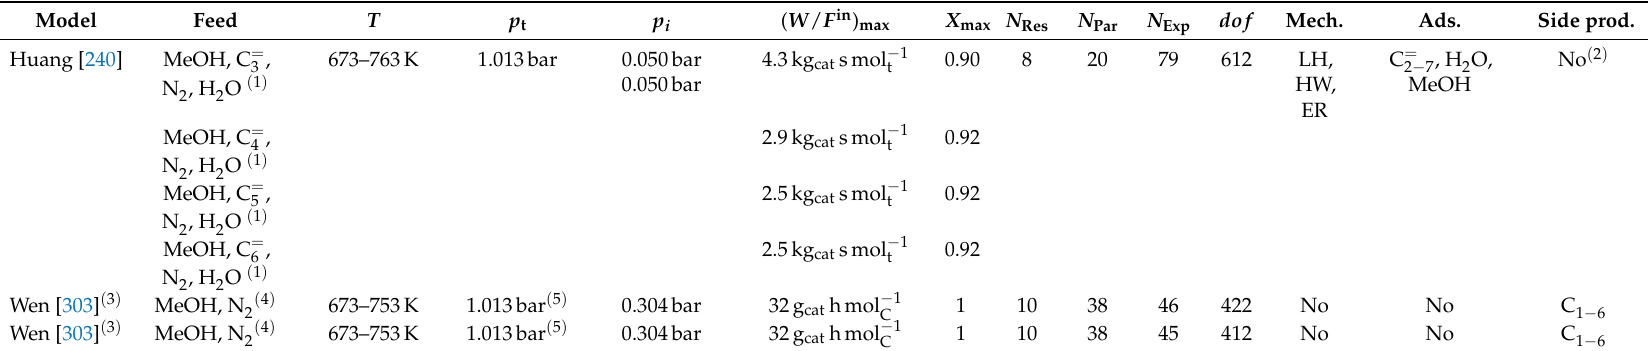
(1) Respective n -alcohol was fed instead of the olefin. (2) Side product formation included in subsequent publication [305]. (3) Similar kinetic model for microfibered (first line) and powdered (second line) catalyst, but different dof . (4) Pure methanol as feed, but model only works when olefins are present (comparable to co-feeding studies). (5) Extracted from